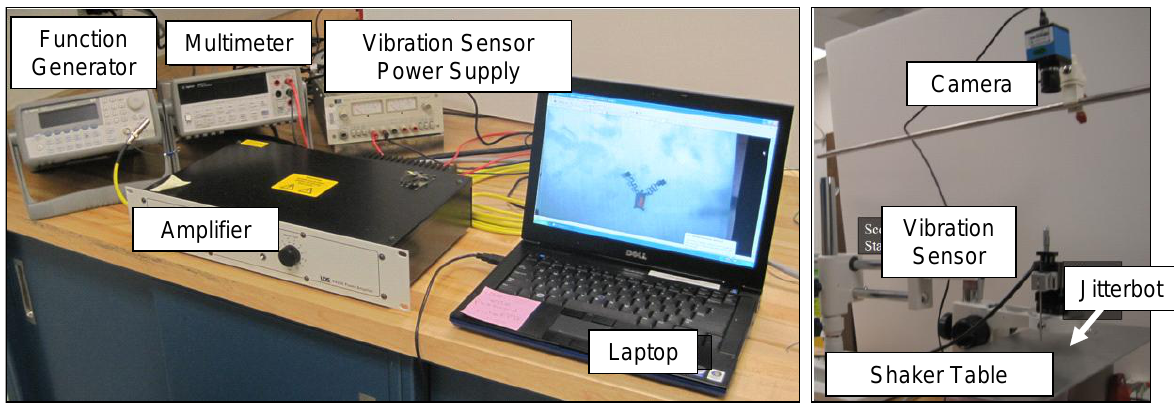
Figure 5. Test setup for